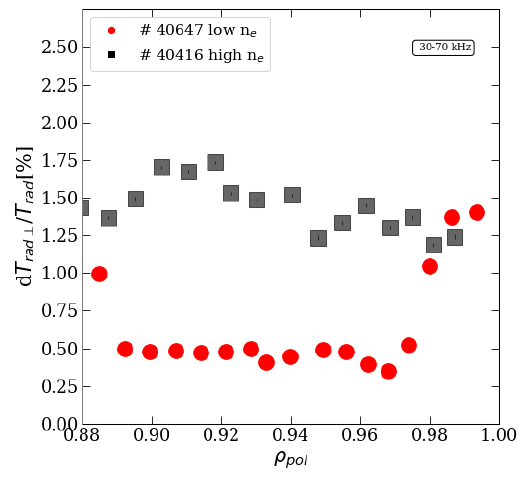
Figure 5. Radial profiles of the relative radiation temperature fluctuations measured by the correlation ECE instrument for two di ff erent density values; low pedestal density #40647 in red and high pedestal density #40417 in black.